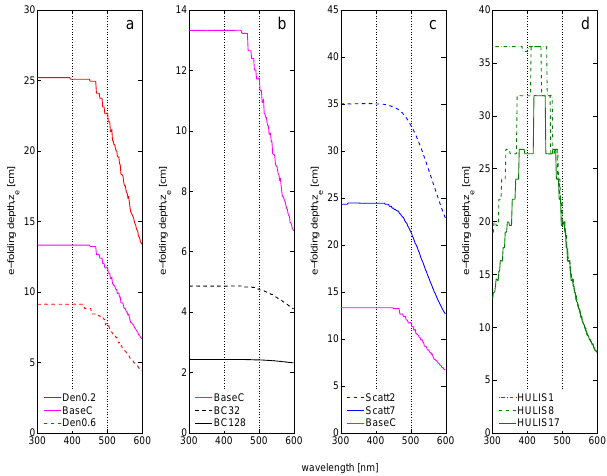
Figure 2. The e -folding depth, z e , as a function of wavelength and dependence on (a) snow density, ρ (case 1); (b) scattering cross section, σ scatt (case 2); (c) absorption due to black carbon, [BC] (case 3); (d) absorption due to HULIS, [HULIS] (case 4). Values of e -folding depth decrease as values of density, black carbon mass ratio and scattering cross section increase across wavelengths be- tween 300 and 600nm. For snowpacks containing black carbon as the only absorber other than ice, the change in e -folding depths are not sensitive to wavelength in the UV and near UV. However, for snowpacks containing e.g. HULIS the change in e -folding depth is sensitive to